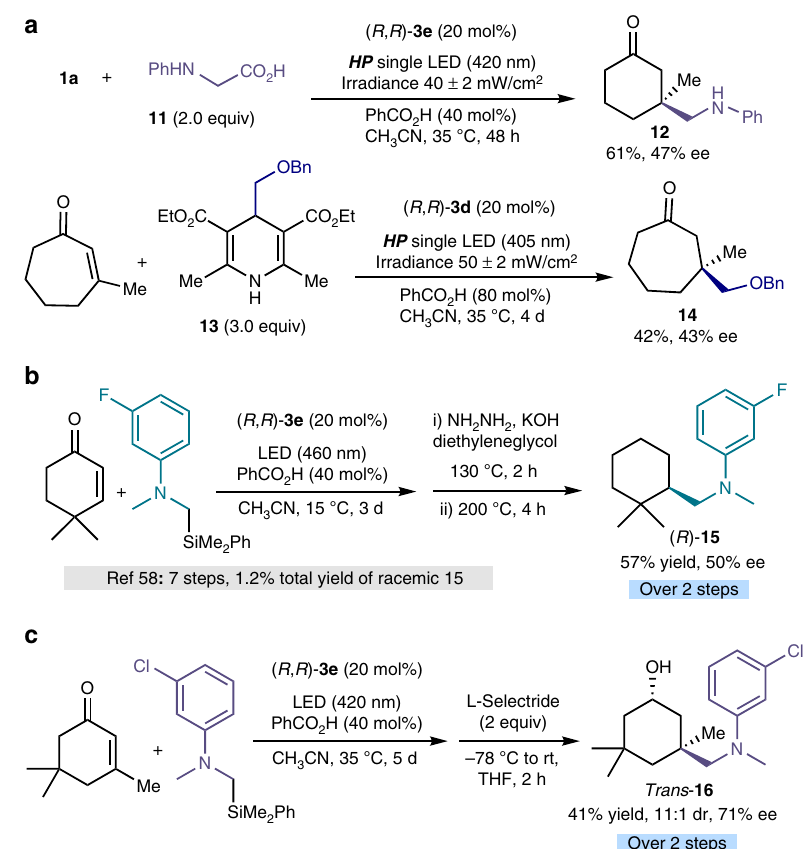
Fig. 5 Expansion of the scope and synthetic utility. a Using different radical precursors than silanes. b , c Enantioselective synthesis of biologically relevant